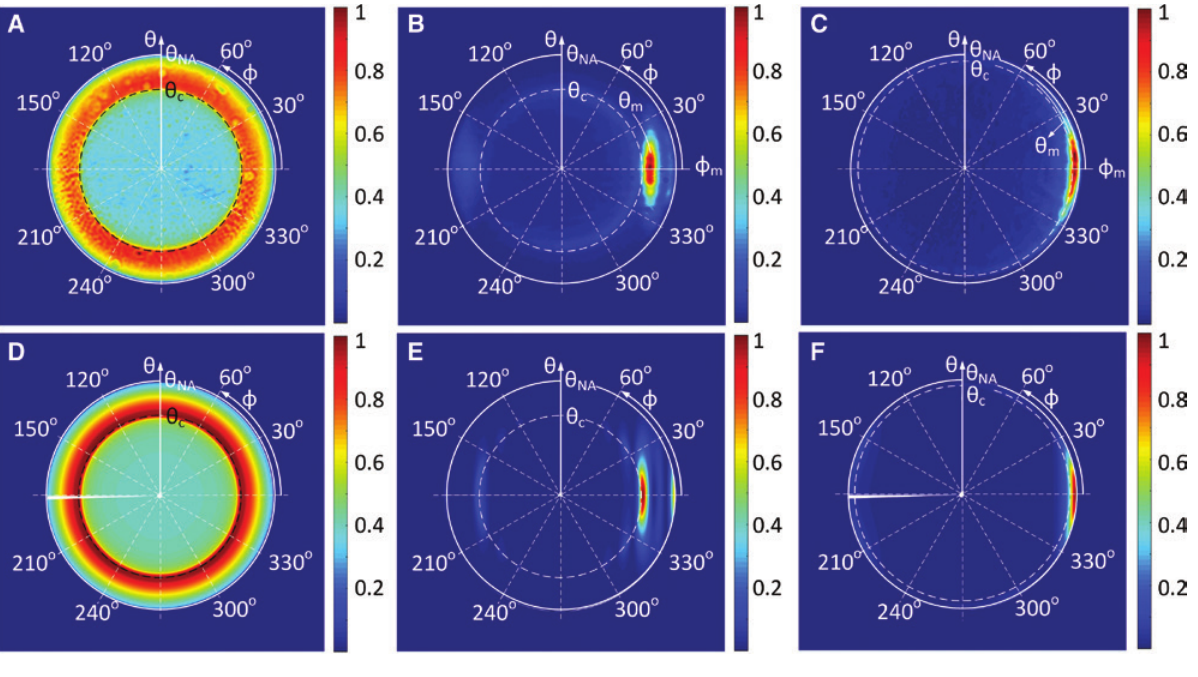
Figure 2: Measured and calculated Fourier images. (A) Measured Fourier image of fluorescence from excited quantum dots (QDs) immobilized on the glass substrate, without a nanowire (NW) = 1.00, n = 1.52). The inner dashed circle at θ = 41 ° represents the critical angle between the air and glass substrate. The outer antenna (n 1 2 c = 67 ° marks the experimentally accessible angular range. (B), (C) Measured Fourier images of excited hybrid nanowires dashed circle at θ NA = 1.00) and water (n = 1.33), respectively. The inner dashed circle at θ (HNWs) immersed in air (n 1 1 of water. ( θ , φ ) is the maximum intensity point. (D–F) Calculated Fourier images show a similar behavior as the experimental Fourier m m